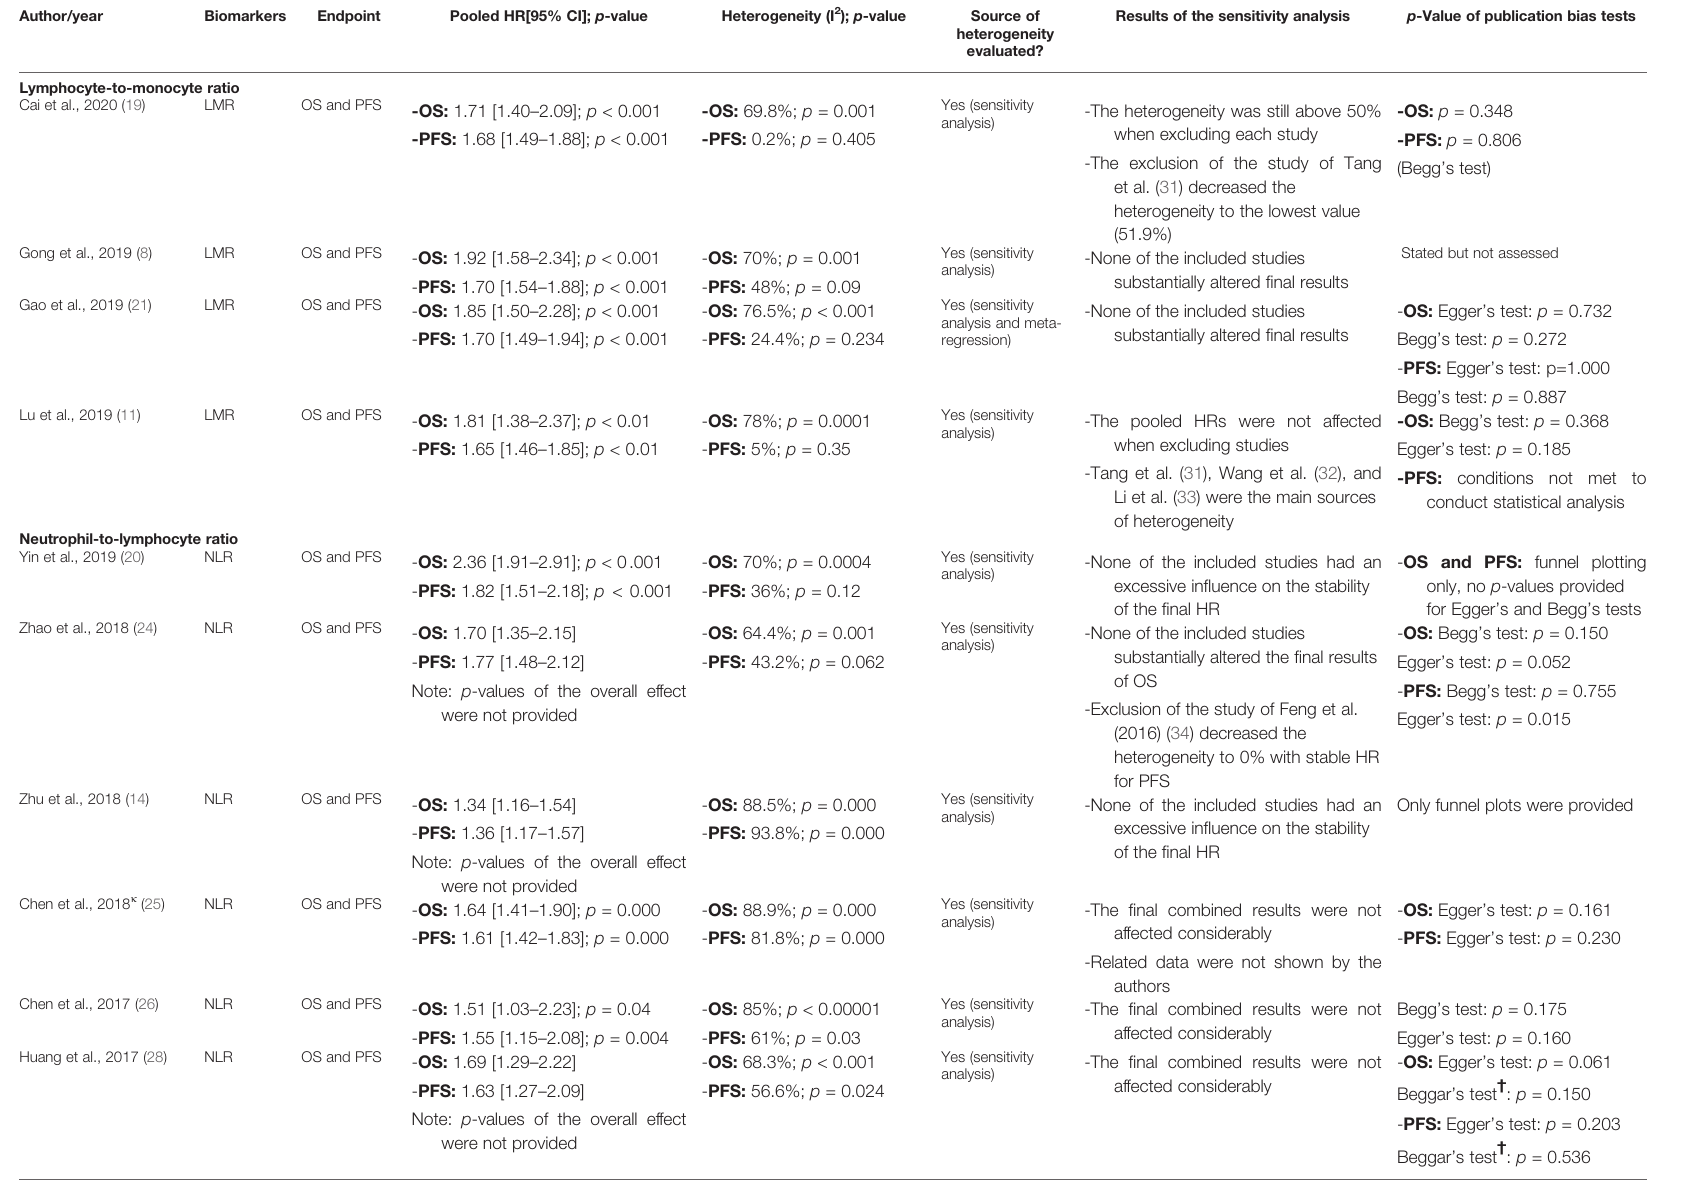
TABLE 2 | Outcomes, heterogeneity, and publication bias in included